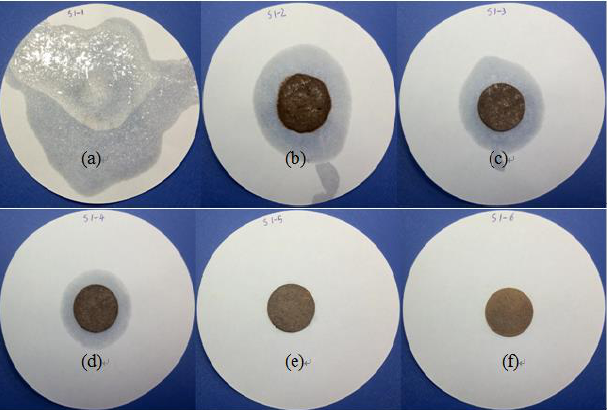
Figure 3. Leakage test results obtained at 60 °C of CA/CIT composites. ( a ) S1-1, ( b ) S1-2, ( c ) S1-3, ( d ) S1-4, ( e ) S1-5, ( f ) S1-6.